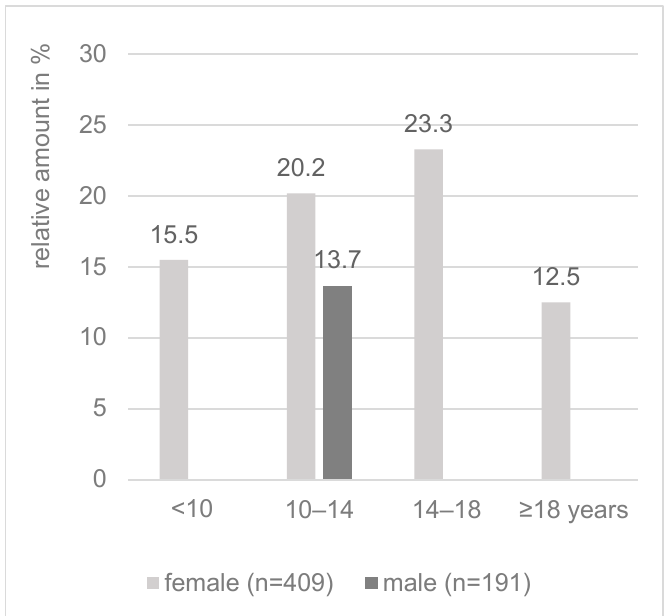
Figure 7. Severely low body weight by age group (ages <10–17 years: <3rd BMI percentile [26]; age ≥ 18 years: BMI <17 kg/m 2 [28]).